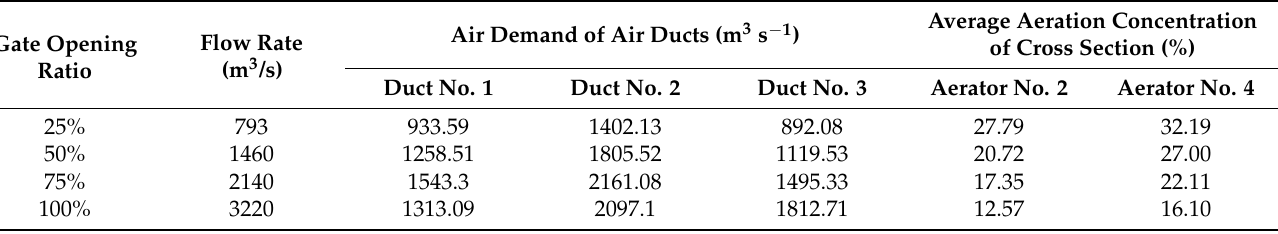
Table 1. Air demand and aeration concentration data from prototype